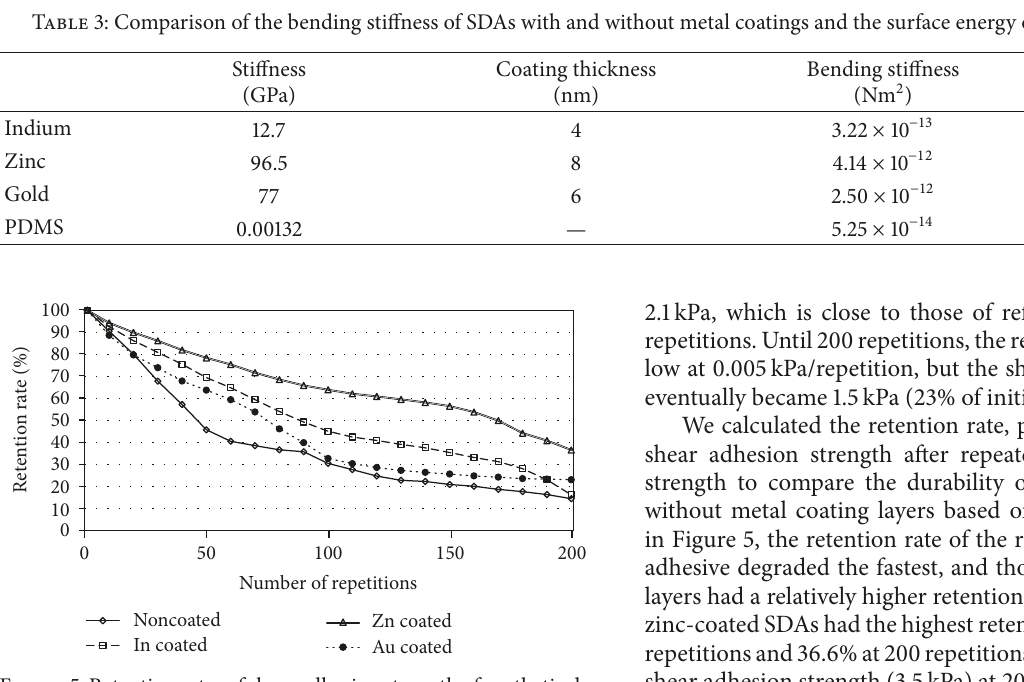
Figure 5: Retention rates of shear adhesion strength of synthetic dry adhesives with and without metal